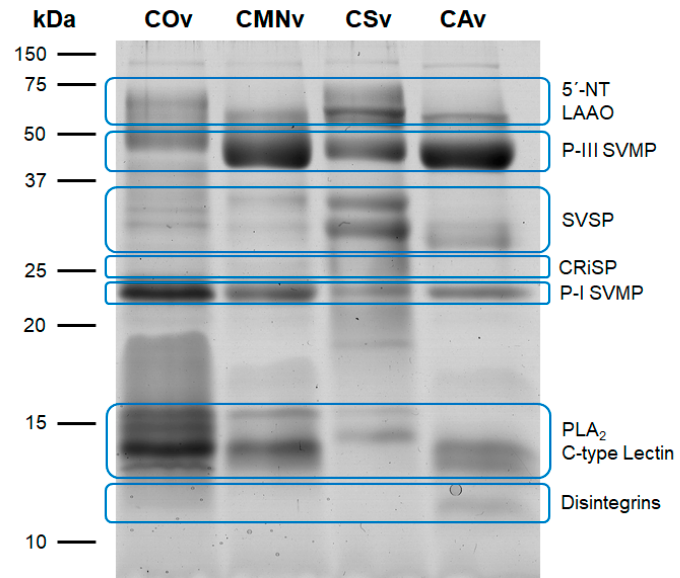
Figure 1. SDS-PAGE venom banding profile for C. ornatus (COv), C. m. nigrescens (CMNv), C. scutulatus (CSv), and C. atrox (CAv). 15 µg of each venom were separated on a 12% SDS-PAGE and stained with Coomassie colloidal stain. Blue ovals enclose the typical molecular weight intervals for the most abundant toxin families according to Mackessy [53]. 5 ′ -NT: 5’-nucleotidases; CRiSP: cysteine- rich secreted proteins; LAAO: L-amino acid oxidases; PLA 2 : phospholipase A 2 ; SVMP: snake venom metalloproteases; SVSP: snake venom serine proteases.